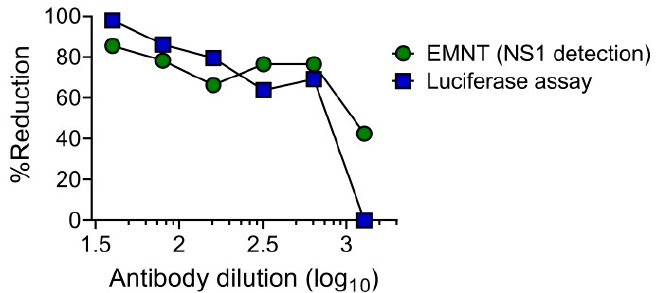
Figure 5. Comparison of EMNT and luciferase assay in detecting neutralizing titers to DENV1-SRIP using anti-flavivirus monoclonal antibody (6B6C-1). The monoclonal antibody was serially diluted two-fold and incubated with DENV1-SRIP at 37 °C for 1 h. The mixture was then titrated on Vero cells. A dose-dependent percentage reduction curve was obtained with the luciferase assay and EMNT.